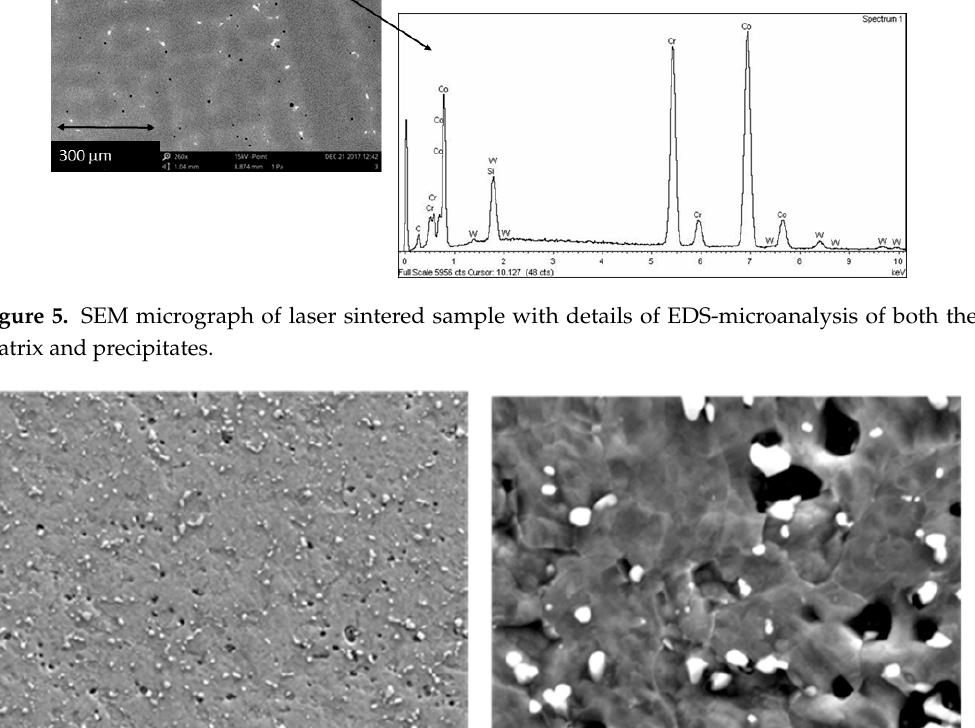
Figure 6. SEM micrographs of laser sintered corroded samples. ( A ) Generalized surface micropitting